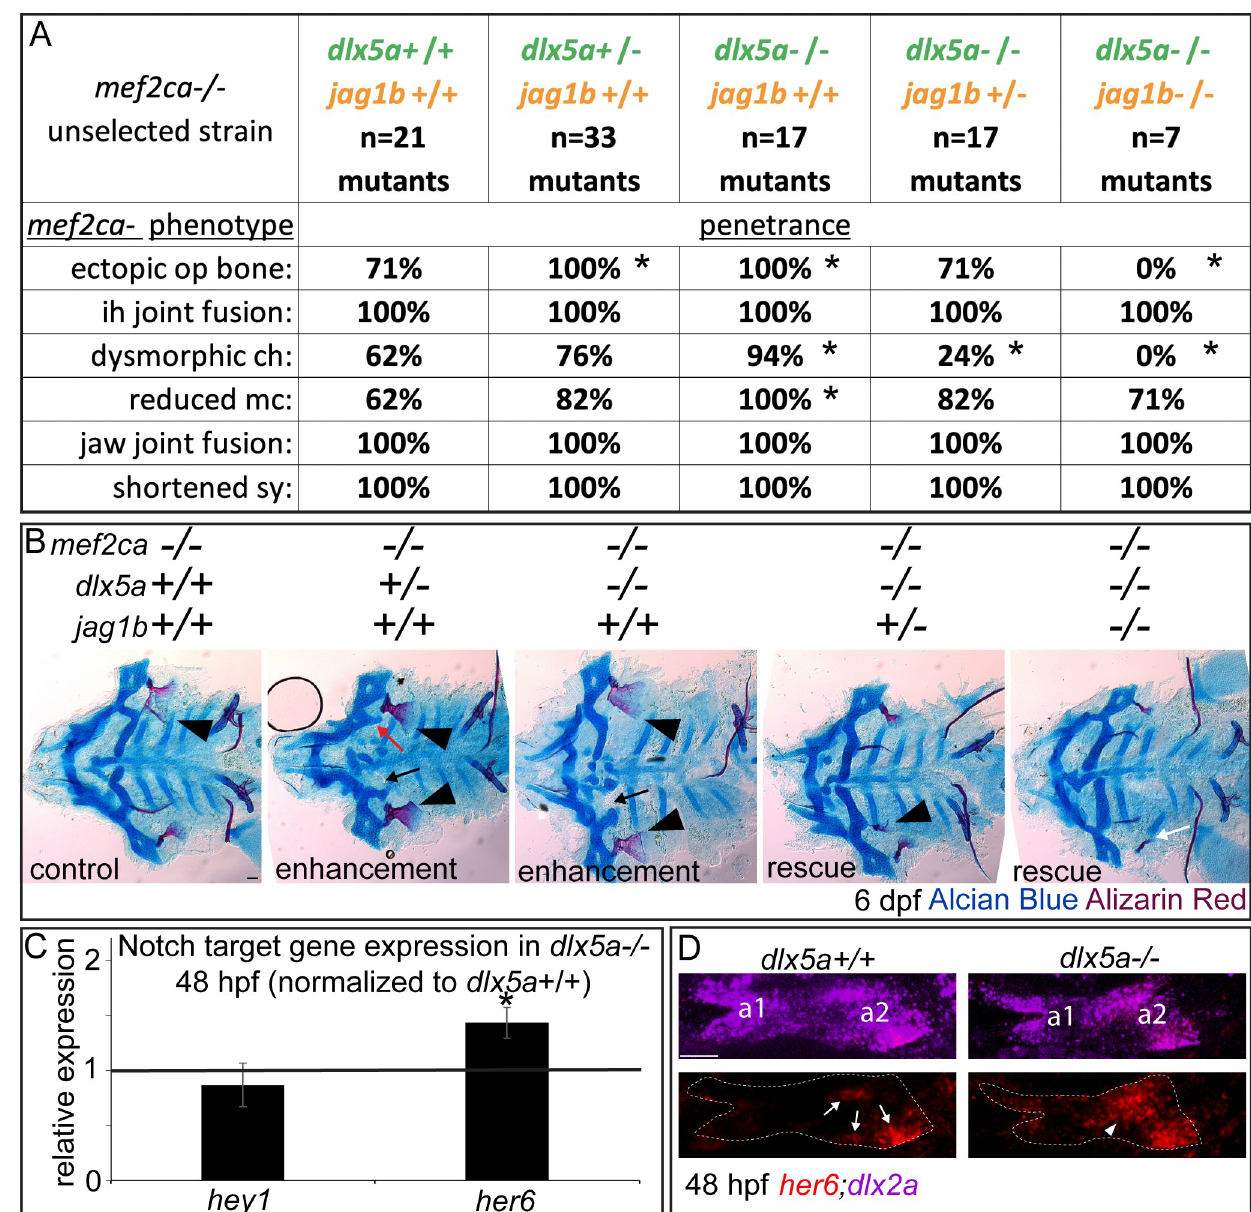
Fig 11. Triple mutants reveal mef2ca modifier epistasis. (A) Animals triple heterozygous for mef2ca , dlx5a and jag1b were intercrossed, offspring were raised to 6 dpf and fixed and stained with Alcian Blue (cartilage) and Alizarin Red (bone). Genotyped skeletal preparations were scored for penetrance of mef2ca -associated phenotypes. Removing functional copies of jag1b from mef2ca;dlx5a double mutants decreases penetrance of mef2ca -associated phenotypes. Asterisks indicate significance at alpha = 0.05 Fisher’s exact test compared with mef2ca-/-;dlx5a+/+;jag1b+/+ . (B) Genotyped mef2ca;dlx5a; jag1b skeletal preparations were flat mounted and imaged. mef2ca mutant associated phenotypes are indicated including ectopic bone (arrowheads), dysmorphic ch (arrows) and ch-to-hm transformation (red arrow). Stick-like opercle bone is indicated with a white arrow. Scale bar: 50 μ m. (C) Head expression of Notch target genes was quantified by RT-qPCR in full-sibling dlx5a mutant and wild-type embryos at 48 hpf. Expression in dlx5a mutants was normalized to wild-type sibling expression levels (black line). Asterisks mark genes with expression levels significantly different in dlx5a mutants compared with dlx5a wild types (T-test at alpha = 0.05). Error bars are standard deviation. (D) Spatial her6 expression was monitored by in situ hybridization in wild types and dlx5a mutants. In wild-type embryos her6 is expressed in three discrete patches in arch 2 (arrows). In dlx5a homozygous mutants, her6 expands ventrally resulting in a larger, more continuous expression domain (arrowhead). dlx2a expression was used to delineate pharyngeal arches one (a1) and two (a2) (dashed outlines). her6 was expanded in 0/4 homozygous wild types and 3/3 homozygous mutants Scale bar: 30 μ m.